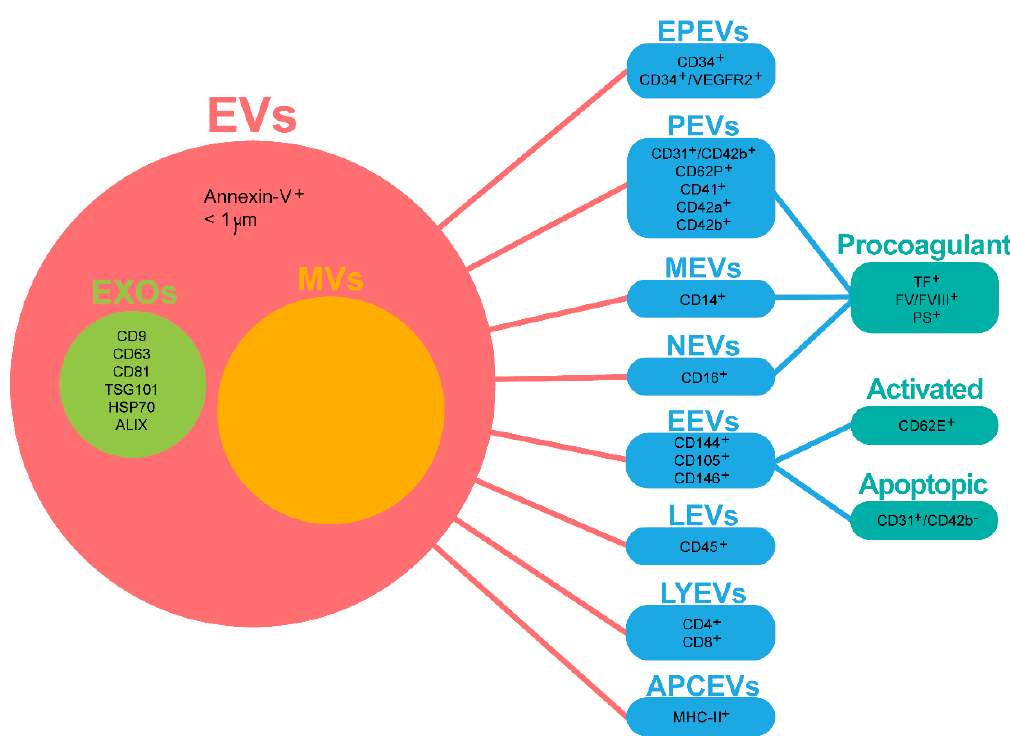
Figure 1. Nomenclature and cell-specific subtypes of circulating extracellular vesicles. In this review, focus will be given to extracellular vesicles (EVs), which include both exosomes (EXOs) and microvesicles (MVs). EXOs were distinguished when appropriate markers were identified. This decision was supported by the known overlap in size/marker definitions between EXOs and MVs (also called ectosomes or microparticles) and by the fact that most studies here included referred to MVs as broad EVs with size < 1 µm and/or annexin-V + . Additionally, cell-specific subtypes of the most common circulating EVs were categorized and uniformed according to the studies here reviewed. For a full list of other markers, please see [51,52,62] . APCEVs, antigen-presenting cell-derived vesicles, EEVs, endothelial-derived vesicles, EPEVs, endothelial progenitor cell-derived vesicles, EVs, extracellular vesicles, EXOs, exosomes, FV/FVII, coagulation factors V/VII, LEVs, leucocyte-derived vesicles, LYEVs, lymphocyte-derived vesicles, MEVs, monocyte-derived microvesicles, NEVs, neutrophil-derived microvesicles, PEVs, platelet-derived vesicles, PS, phosphatidylserine and TF, tissue factor .